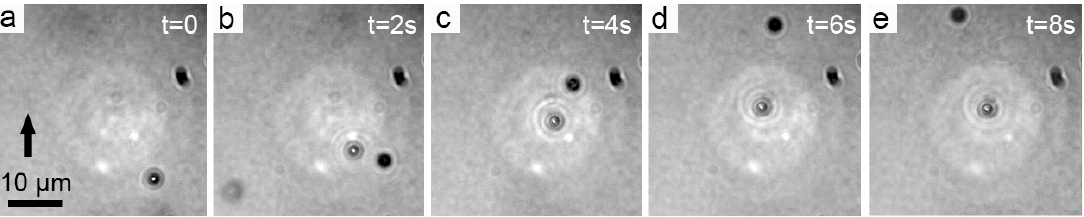
Figure 6. A video sequence recorded during trapping of a PS bead: ( a , b ) bead flowed up due to heat convection of laser spot ( c ) bead entered into the trap and ( d , e ) remained in the trap while others on the background kept flowing up. Arrow indicates the bead of interest flowing in an upward direction.